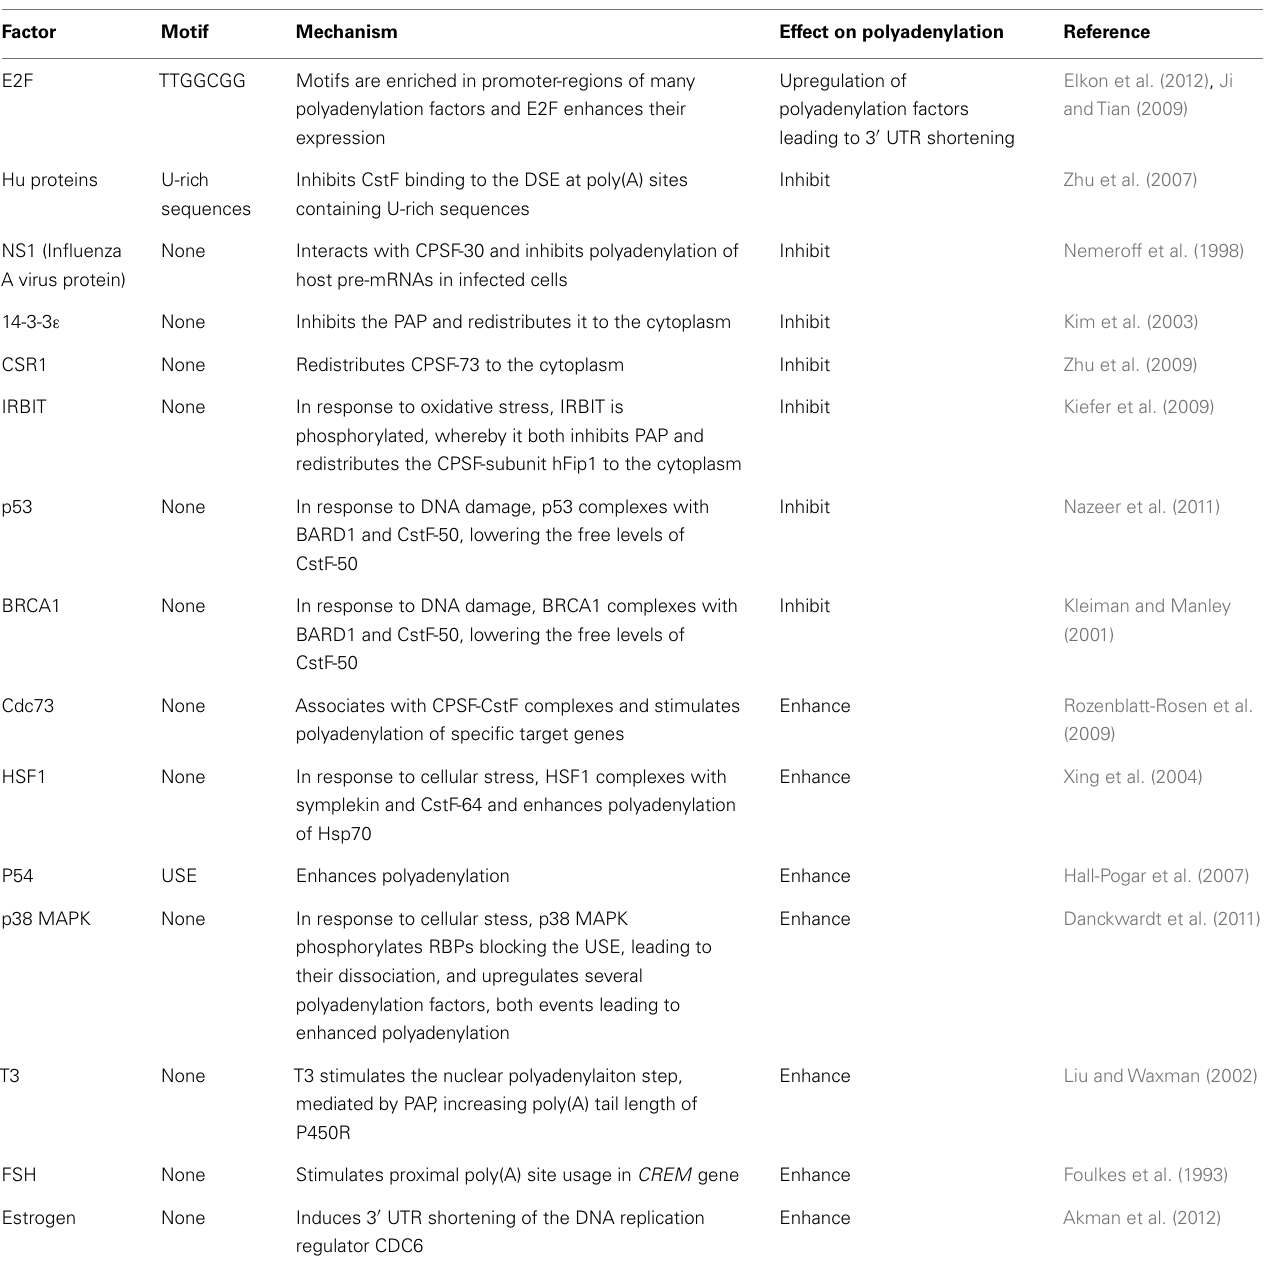
Table 3 | Non-splice factors affecting